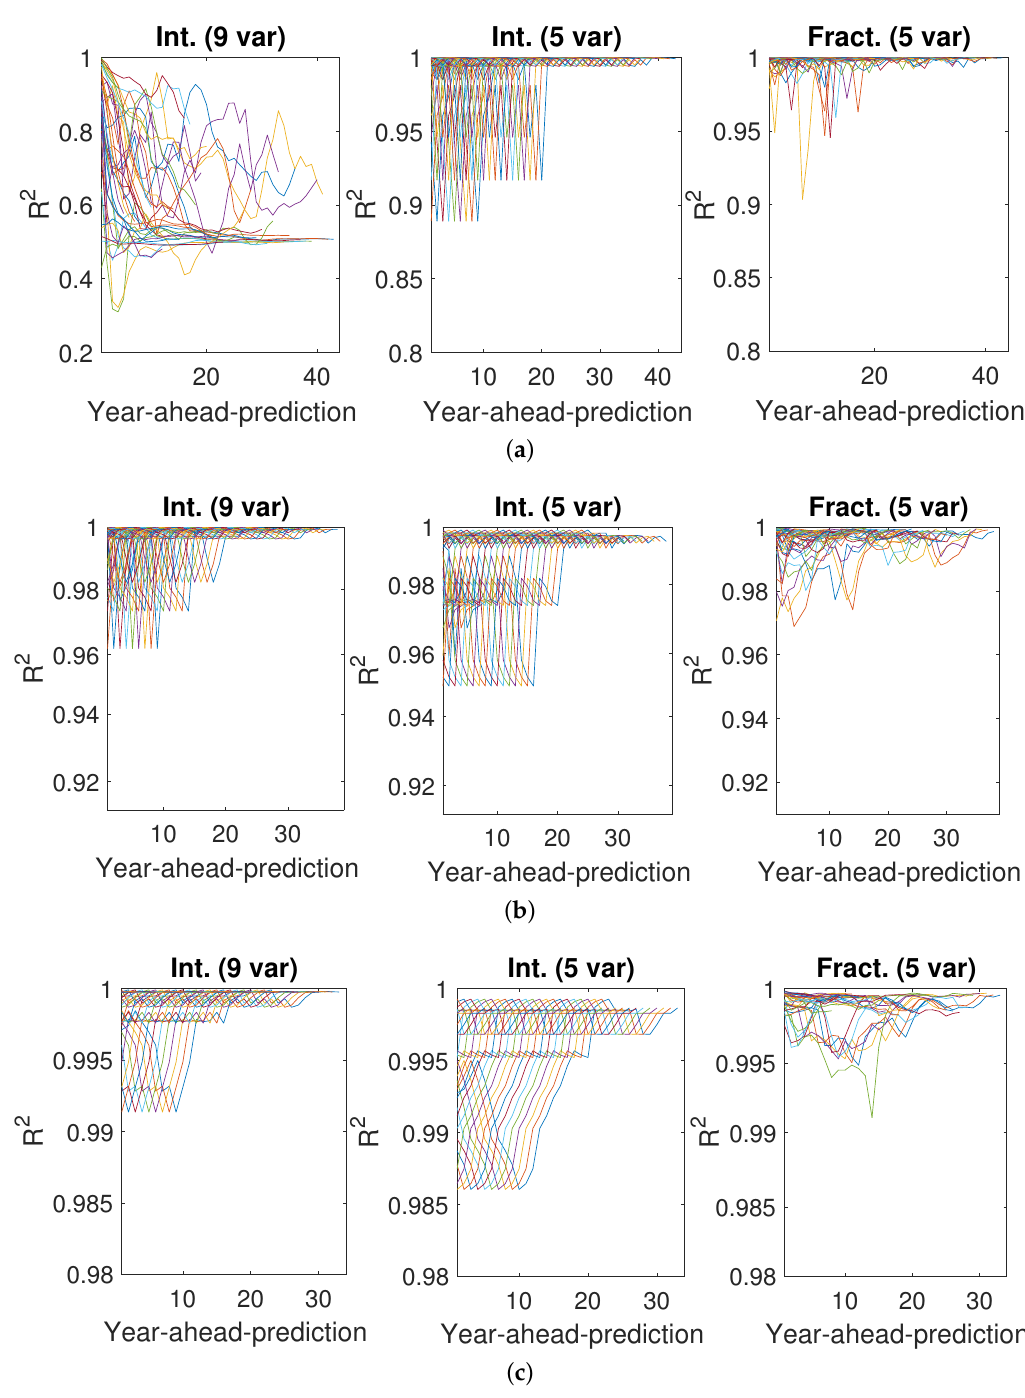
Figure 5. R 2 values of GDP estimates for Australia. Estimates were obtained with models (1) (left), (2) (middle), and (3) (right). The models were obtained with data for different numbers of years: ( a ) N = 5 (top) ( b ) N = 10 (center) ( c ) N = 15 (bottom). The models were used to estimate the GDP for as many years as possible after the period for which they were built. The scale of the y -axis is not the same for all models and all values of N